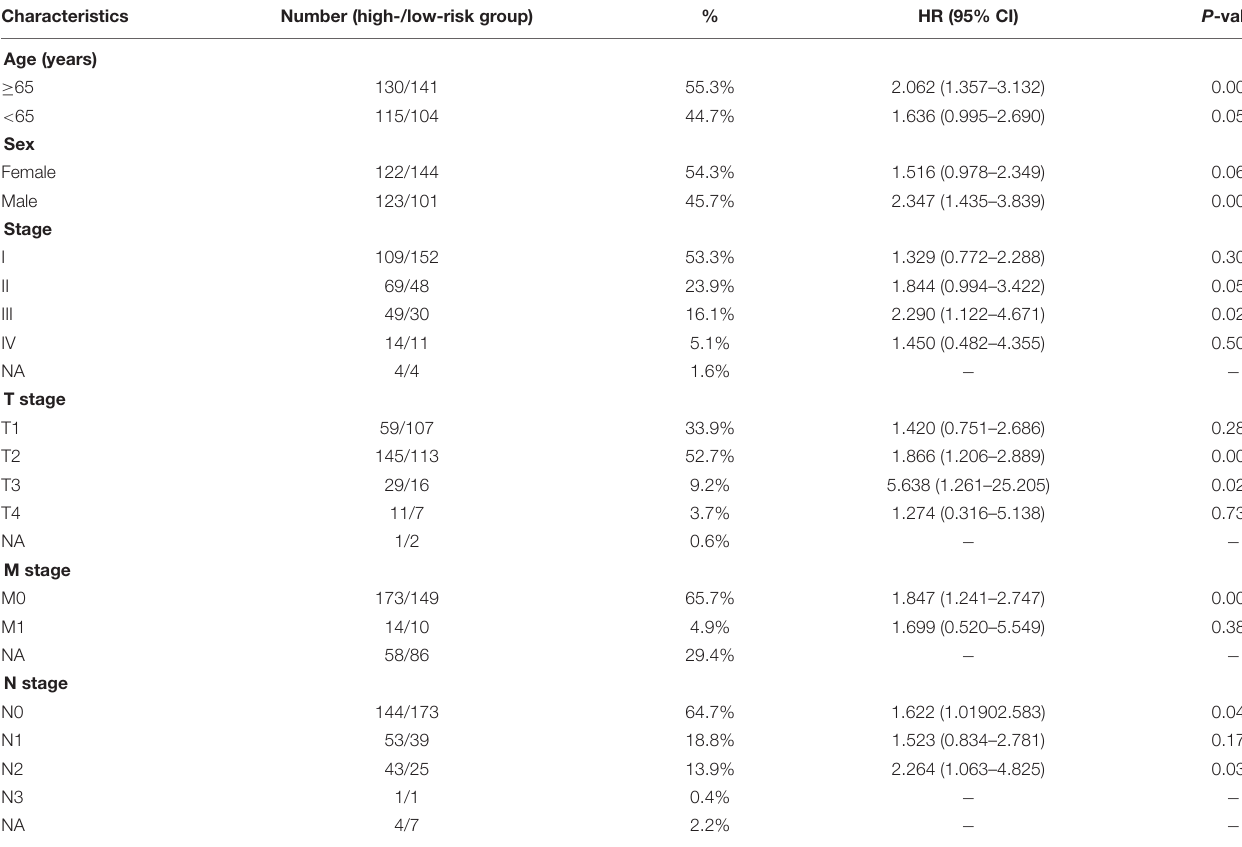
TABLE 1 | Prognostic roles of the ARGs signature with different demographic and clinical characteristics in TCGA training set (OS).